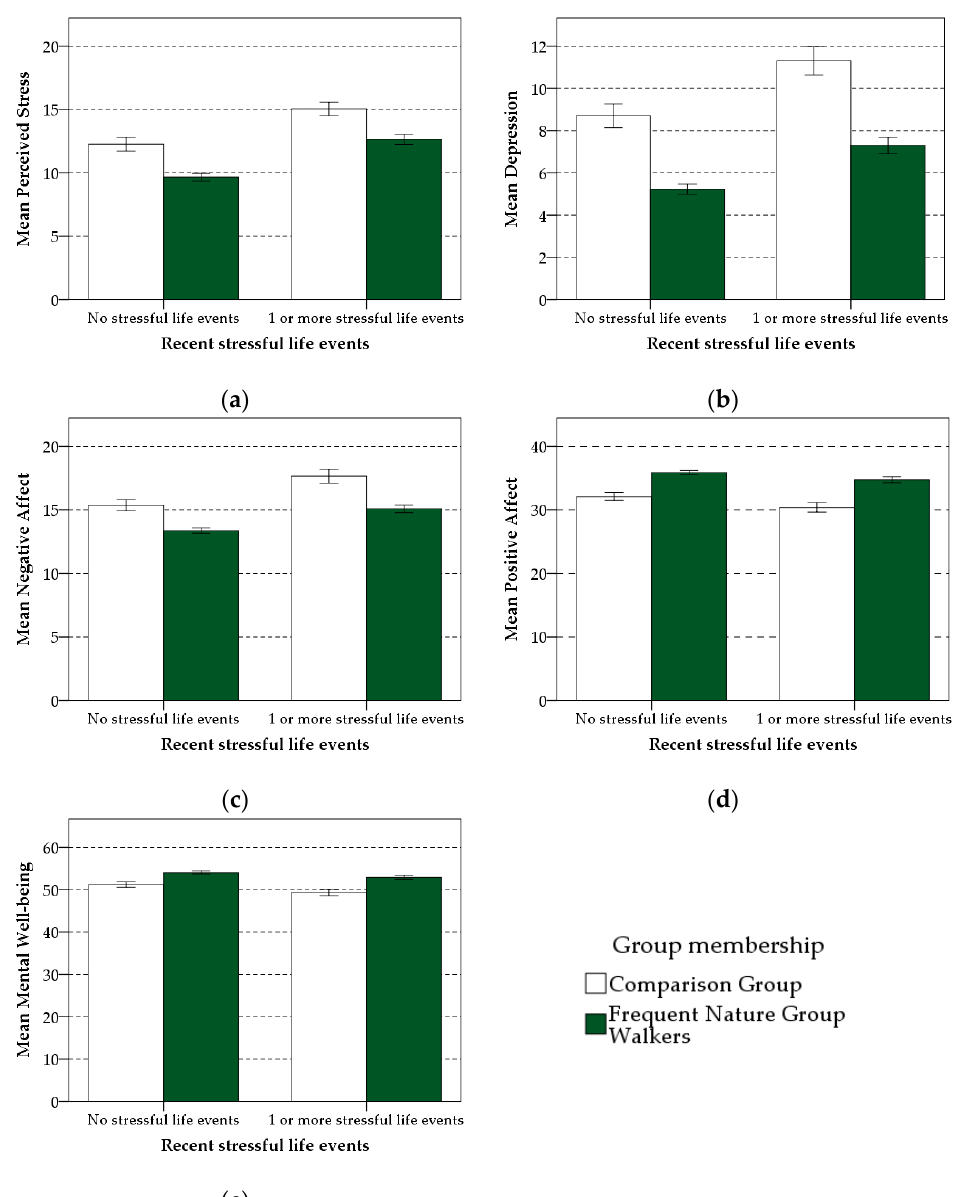
Figure 4. Mean perceived stress ( a ), depression ( b ), negative affect ( c ), positive affect ( d ), and mental well-being ( e ) as a function of recent stressful life events and frequent nature group walk participation. The frequent group walkers subsample consists of individuals from the main sample who attended a group walk in the natural environment at least once per week ( n = 930). Error bars are ± 1 SE of the mean.